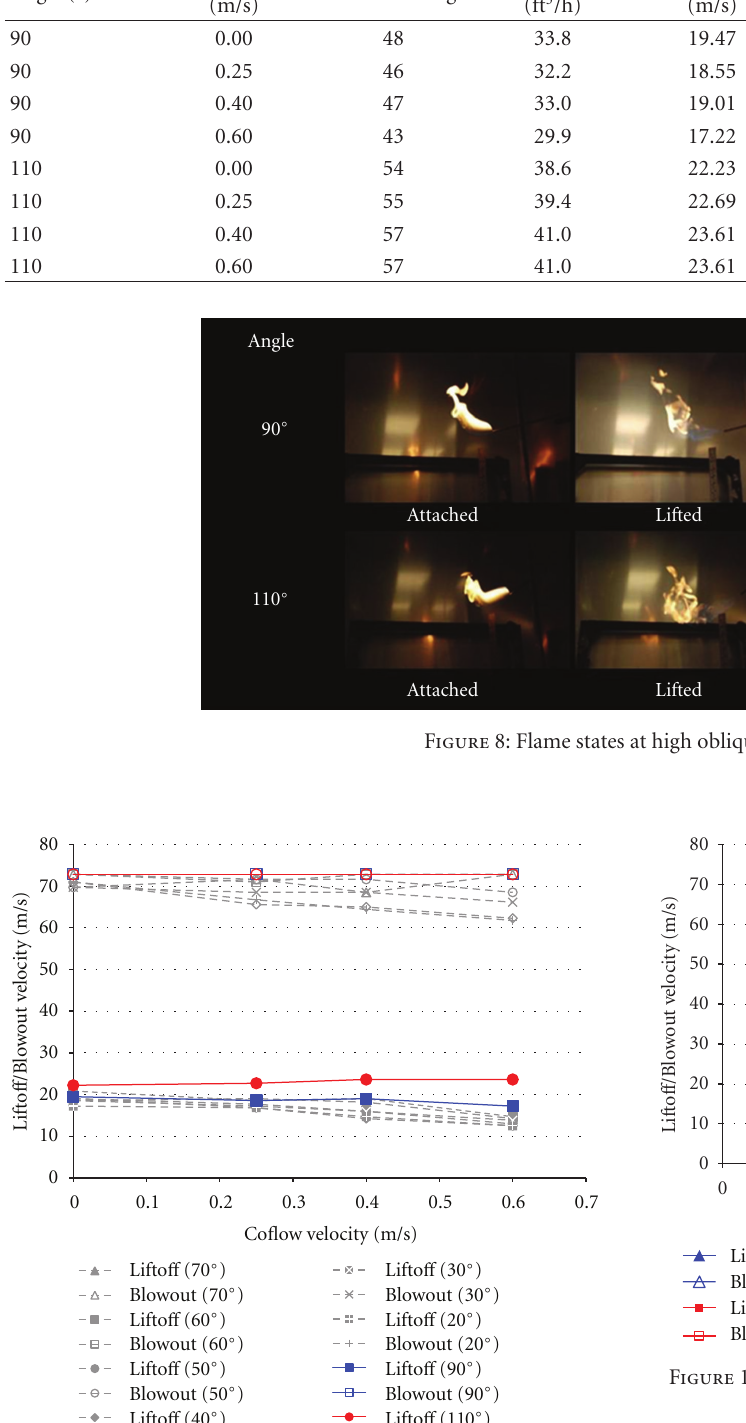
Figure 9: Stability limits versus coflow velocity including 90 ◦ and 110 ◦ .